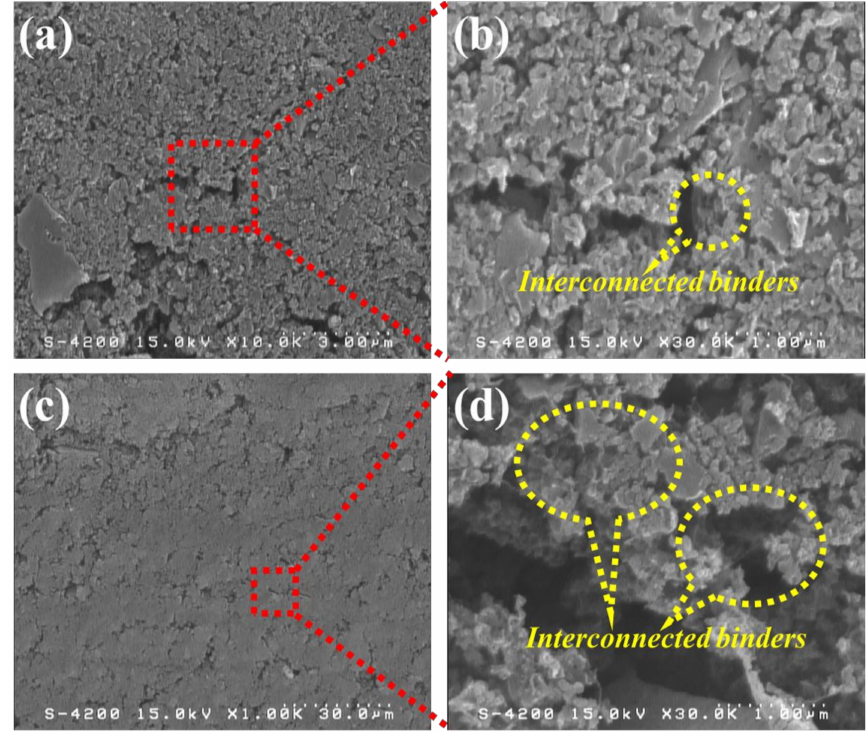
Figure 1. SEM micrographs of the high-mass loading hierarchically porous activated carbon electrode: ( a , b ) top-view and ( c , d ) cross-section. Scale bars of ( a – d ) are 3, 30, and 1 µ m,